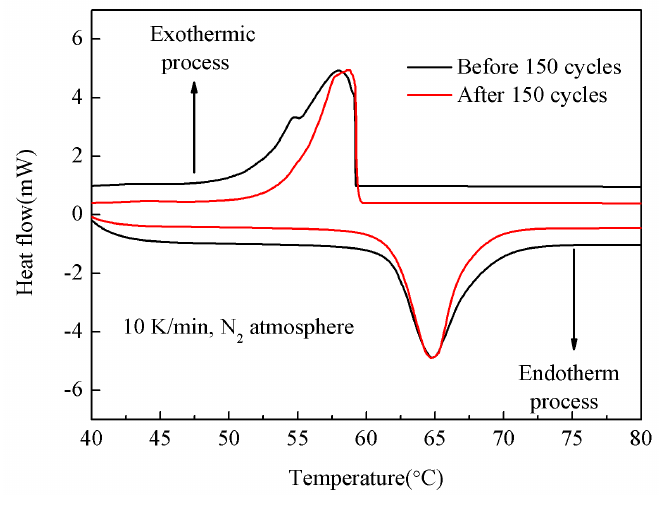
Figure 6. DSC curve of PA/mullite Form-Stable Phase Change Materials (FSPCM) before and after 150 thermal cycles.